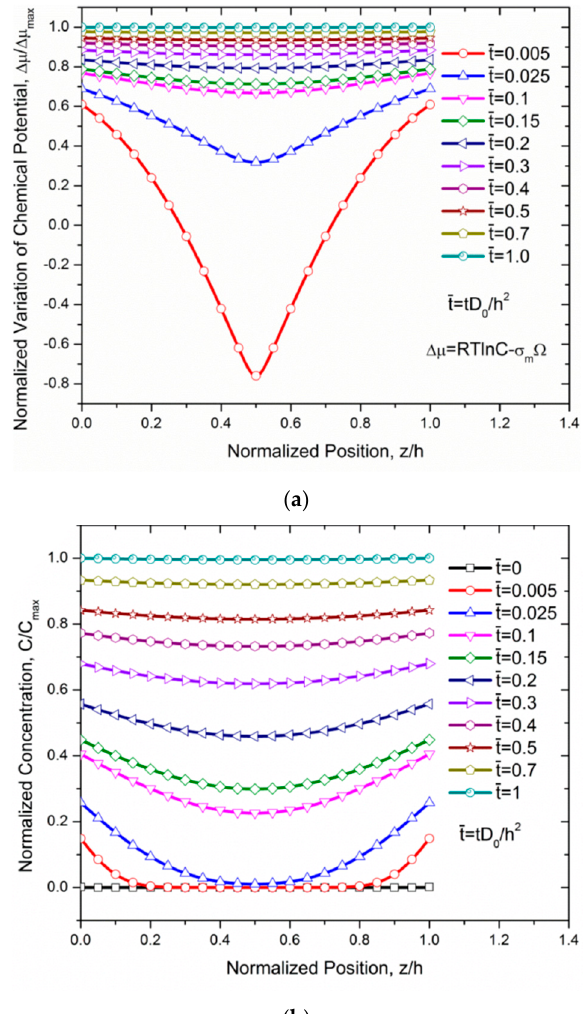
Figure 14. The diffusion of Al in Ni splat during the alloying of Ni/Al coating [81]; ( a ) the distribution of the variation of chemical potential; ( b ) the distribution of concentration of Al. Note that in this work, stress relaxation and the change of the energy barrier of atomic jump are not considered.